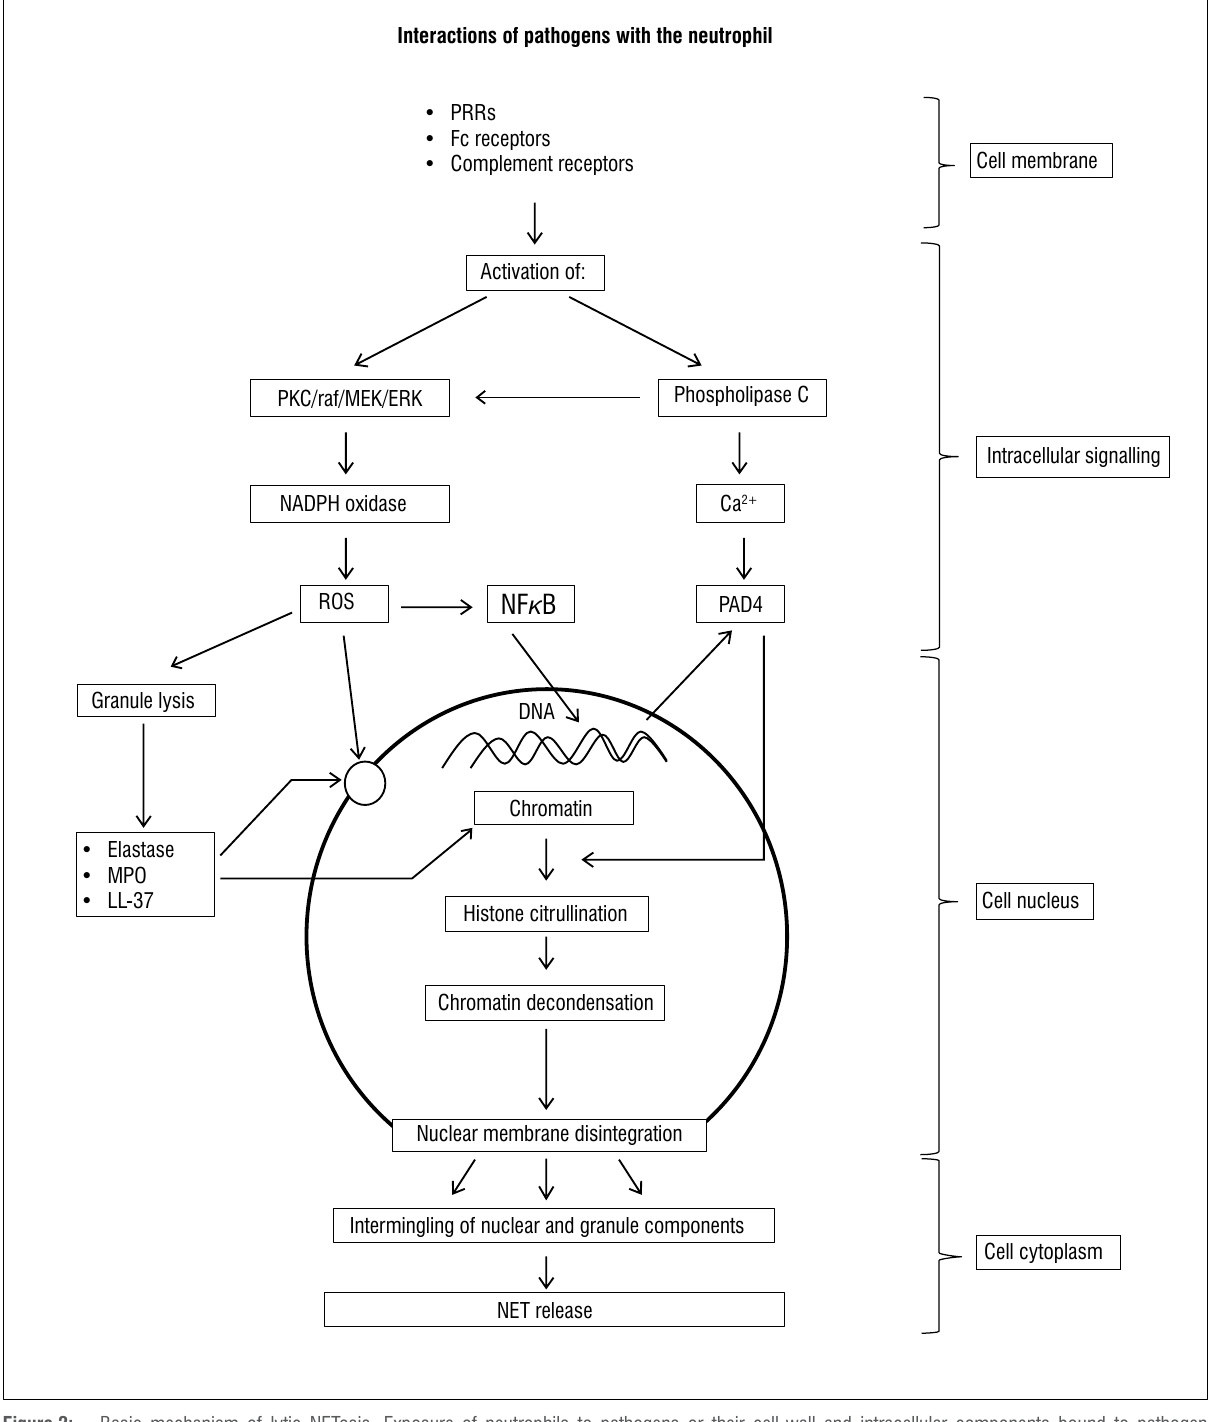
Figure 2: Basic mechanism of lytic NETosis. Exposure of neutrophils to pathogens or their cell-wall and intracellular components bound to pathogen recognition receptors (PRRs) or receptors for antibody (Fc) or complement components is linked to activation of: (1) the protein kinase C (PKC)/ raf/erk kinase (MEK)/extracellular signal regulated kinase (ERK) intracellular signalling axis, which, in turn, activates the membrane-bound, electron-transporting, reactive oxygen species (ROS)-generating complex, nicotinamide adenine dinucleotide phosphate (NADPH) oxidase; and (2) the enzyme phospholipase C which cleaves membrane phosphatidylinositol to generate diacylglycerol (which also activates NADPH oxidase) and inositol triphosphate, which mobilises calcium (Ca 2+ ) from intracellular stores. ROS initiate activation of the latent cytosolic transcription factor, nuclear factor kappa B (NF K B), which translocates to the nucleus and induces, amongst others, the gene encoding the Ca 2+ -dependent, pro-NETotic enzyme peptidylarginine deiminase 4 (PAD4). ROS also promote disruption of the membranes of cytosolic granules leading to release of granule antimicrobial proteins and enzymes, including LL-37, which act in concert with ROS to augment nuclear membrane disintegration, while elastase and myeloperoxidase (MPO) also mediate chromatin decondensation. Nuclear membrane disruption enables PAD4 to access the nucleus, which, in turn, triggers the series of events culminating in neutrophil extracellular trap (NET) formation. This involves PAD4-mediated citrullination of nuclear histones followed by chromatin decondensation, and intermingling of nuclear and granule antimicrobial components in the cytoplasm to form a matrix which is released extracellularly as